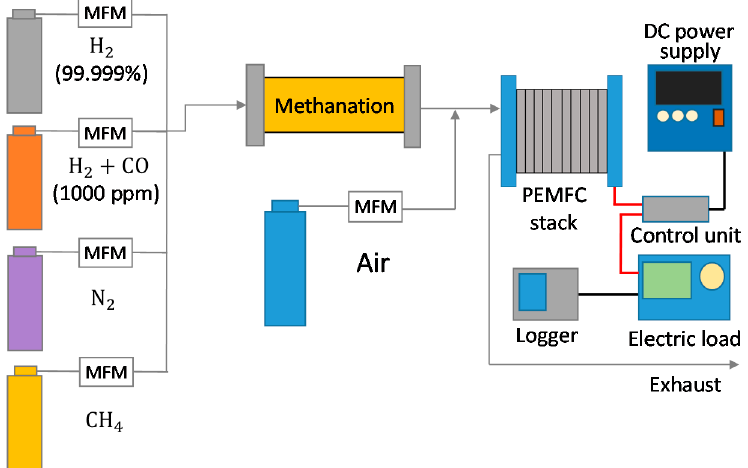
Figure 2. Schematic diagram of the experiment using a PEMFC stack to supply hydrogen-containing impurities.